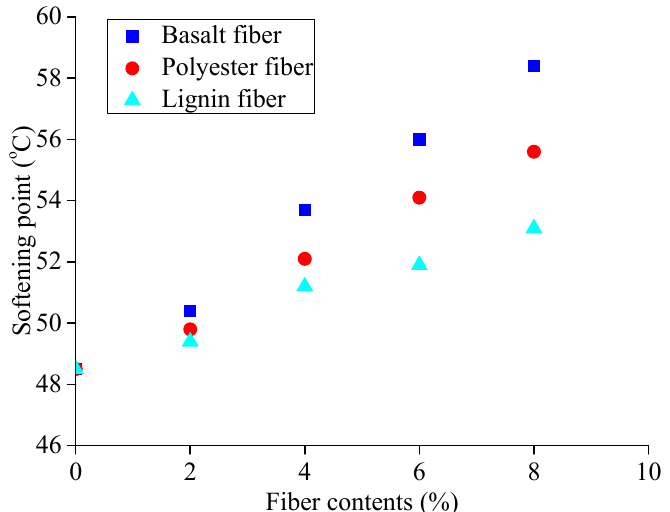
Figure 10. Softening point test results for three kinds of fiber-reinforced asphalt binder. Figure 9. Penetration test results of three kinds of fiber-reinforced asphalt binder, where the testing temperature was set to 25 ◦